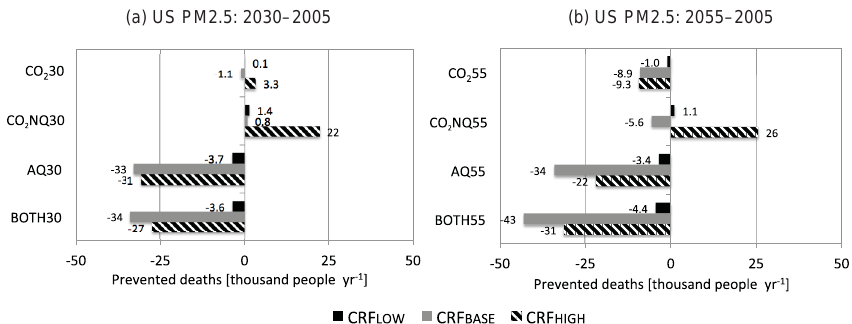
Figure 8. Same as Fig. 5 but for the difference between ModelE2-TOMAS and ModelE2-OMA.